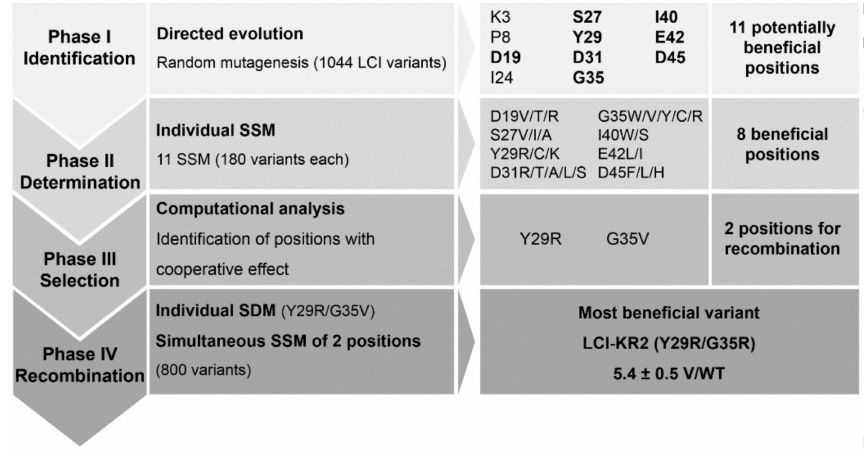
Figure 1. Overview of the knowledge-gaining directed evolution (KnowVolution) strategy of the polypropylene anchor peptide campaign. The campaign was performed to increase the binding strength of liquid chromatography peak I peptide, 47 aa (LCI ) toward polypropylene in the presence of the non-ionic surfactant Triton X-100. Phase I: a random mutagenesis library was generated and screened and yielded 11 potentially beneficial positions (K3, P8, D19, I24, S27, Y29, D31, G35, I40, E42, and D45). Phase II: each position was saturated individually (site-saturation mutagenesis (SSM), using NNK-codon) and two 96-well microtiter plates (MTPs) were screened per position. Phase III: the identified beneficial positions and substitutions were analyzed computationally to group beneficial positions for exploiting cooperative effects. Phase IV: positions Y29 and G35 were recombined by site-directed mutagenesis (SDM), yielding the variant LCI-Y29R/G35V and by simultaneous SSM, yielding variant KR-2